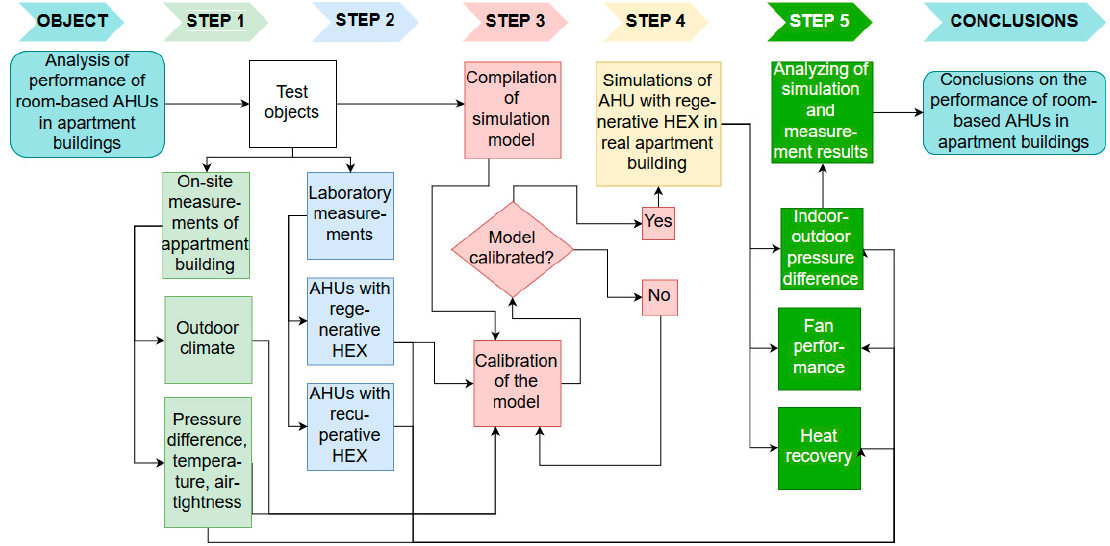
Figure 2. The flow chart of the performed studies. AHU: air handling unit.